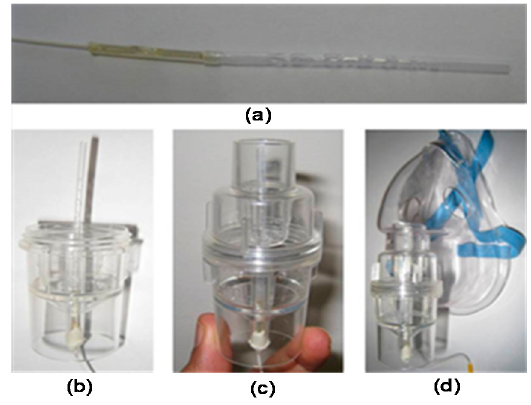
Figure 13. Etched PFBG breath rate monitoring setup. ( a ) Packaged sensor; ( b – d ) the sensor attached to a nebulizer mask.